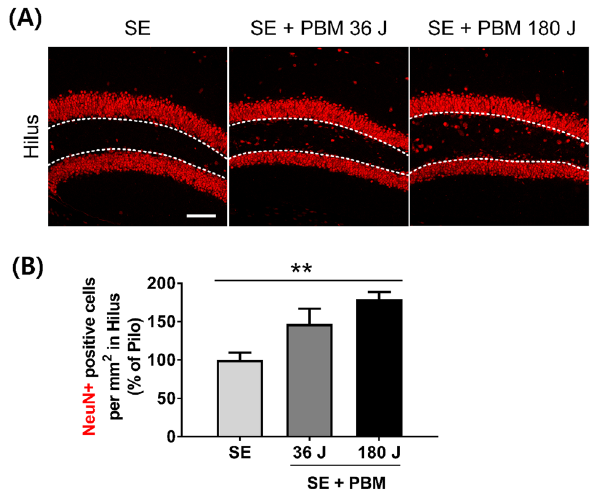
Figure 2. PBM upregulated neuronal population in hilus after SE. (A) Representative coronal section views of Z-stacks obtained by confocal microscopy show the localization of NeuN (for mature neuron, red) positive cells in hilus (area between dotted line) on the dentate gyrus of the hippocampus. Scale bar 100 µm. ( B ) Quantification of the number of mature neurons (NeuN) in hilus are shown. The treatment of 180 J PBM shows statistically larger population of hilar interneurons compared to SE only at day 21 after induced SE. The quantitative data are presented as the mean ± SEM. **P < 0.01. This figure was generated with Microsoft Visio version 2016 (Microsoft, Redmond, WA,